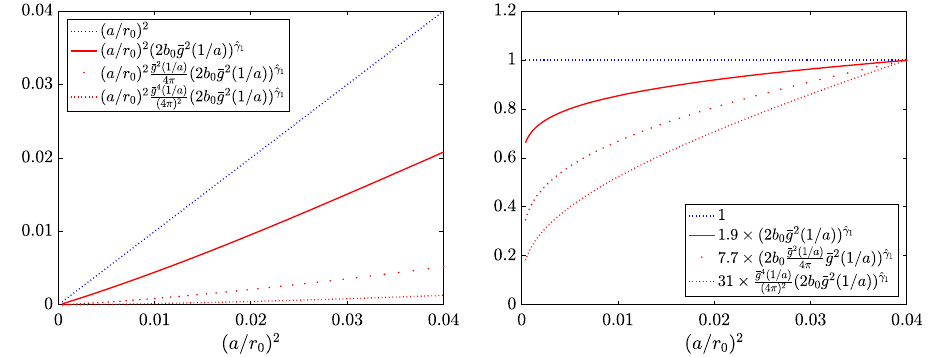
Fig. 3 Illustration of discretization errors, (cid:4) P ( a ) , Eq. (5.3) compared to naive a 2 behavior. We use α( 5 / r 0 ) = ¯ g 2 ( 5 / r 0 )/ 4 π = 0 . 25, where r 0 ≈ 0 . 5fm [37] and set matrix elements to one in units of r 0 and set c ( i ) at a / r 0 = 1 / 5 such that the shape is clearly